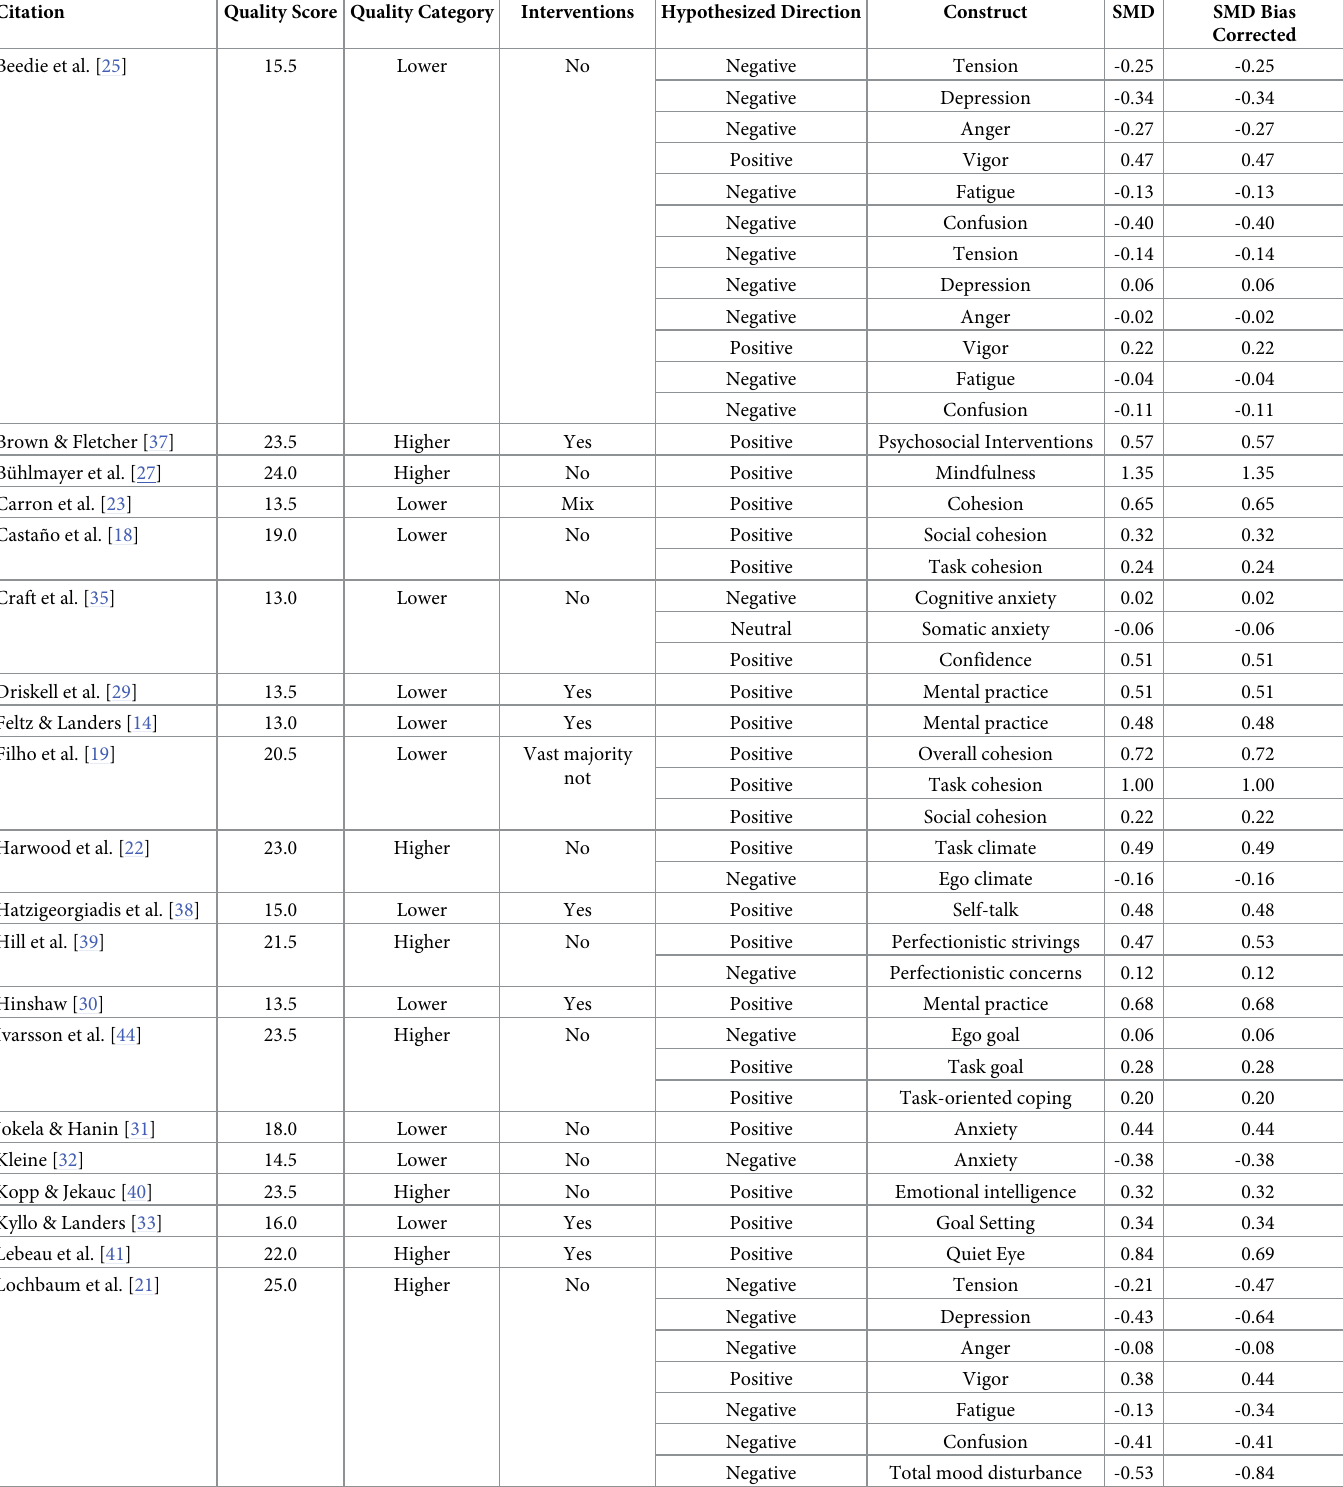
Table 2. Citation, quality metrics, study design, hypothesized performance effect, construct, standardized mean difference (SMD) and bias corrected values for 30 meta-analyses.